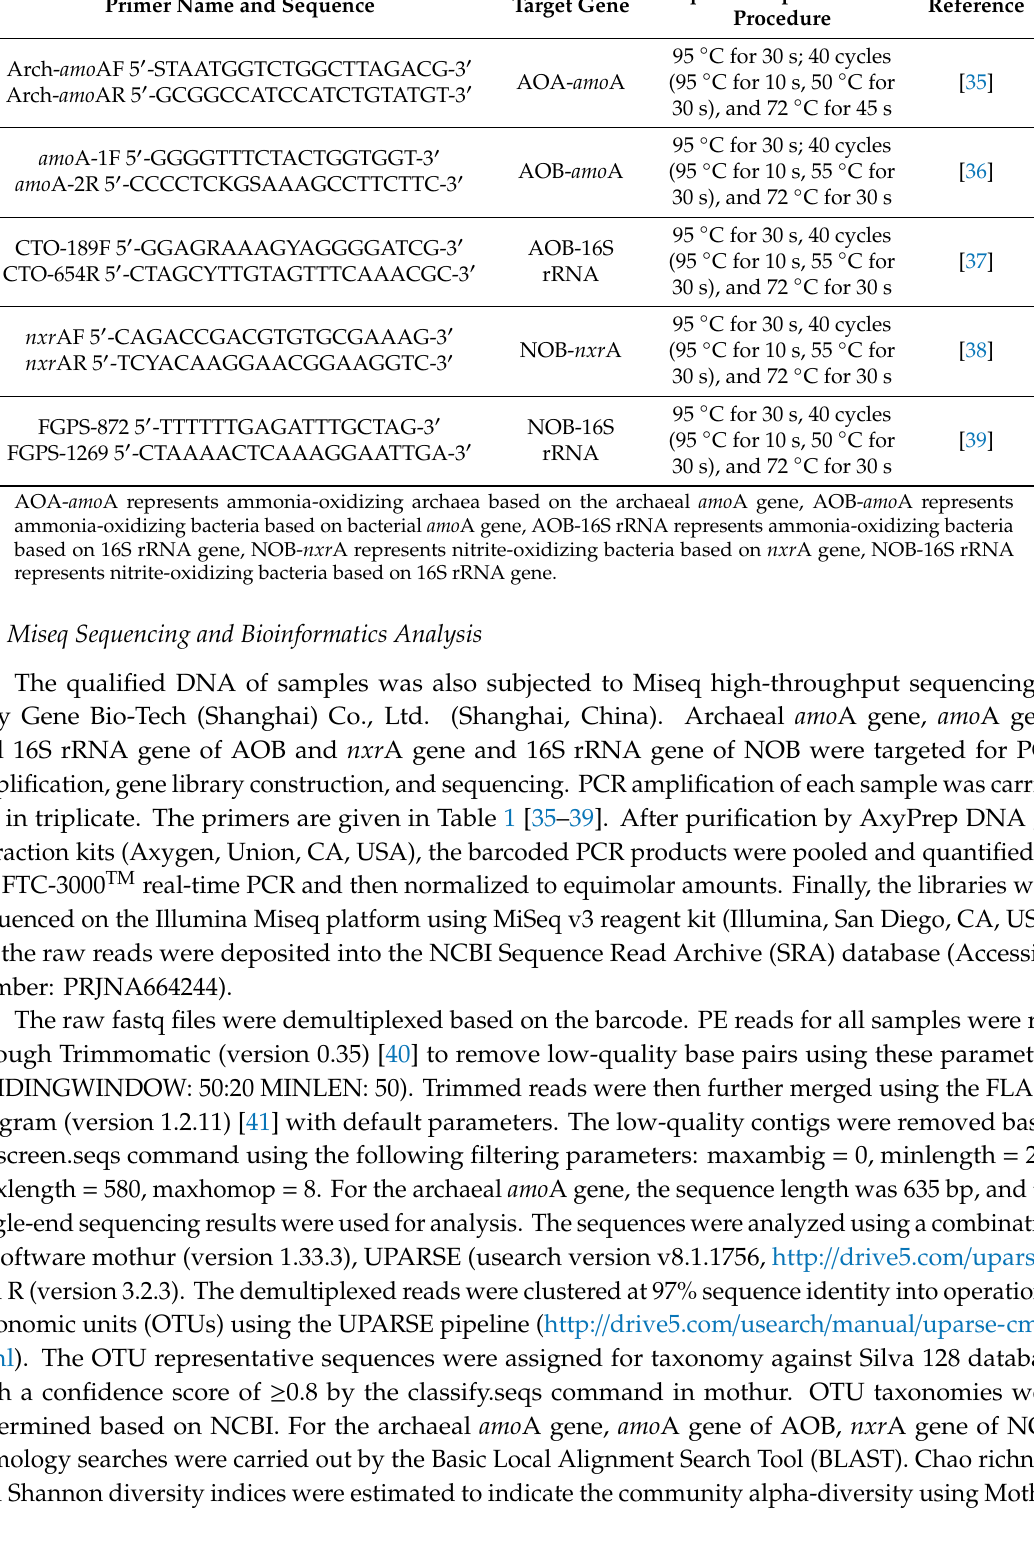
Table 1. Primers and target genes used for qPCR and PCR amplification in this study. Primer Name and Sequence Target Gene